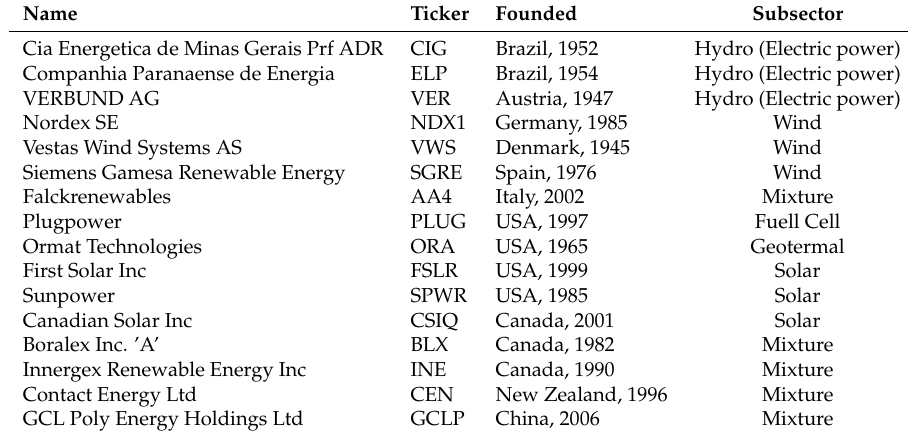
Table 2. Description of the 16 individual clean energy stock prices belonging to the SPGCE index.